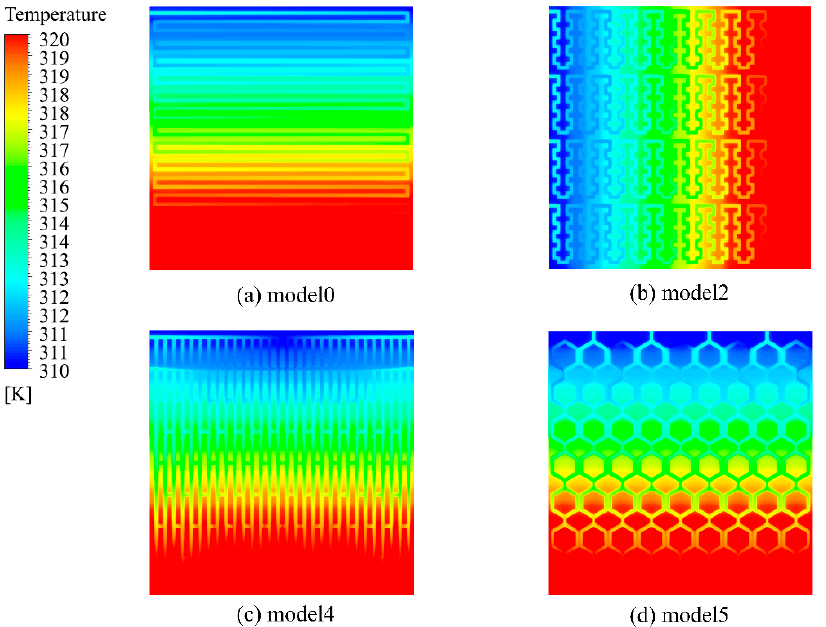
Figure 15. Effect of bottom non-uniform temperature distribution.